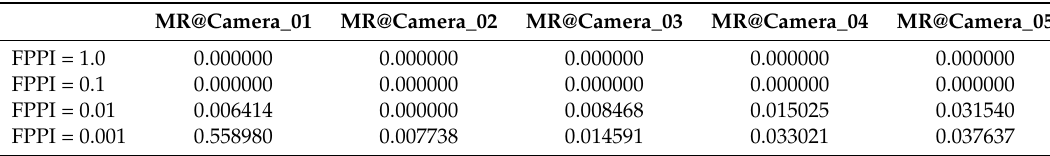
Table 2. Accuracy table @ Cameras_01–05, informed-filters.